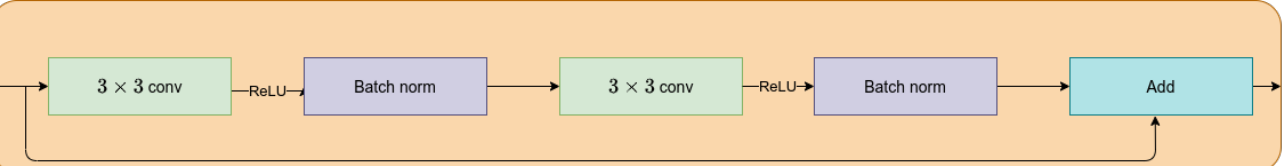
Figure 3. The scheme of a residual